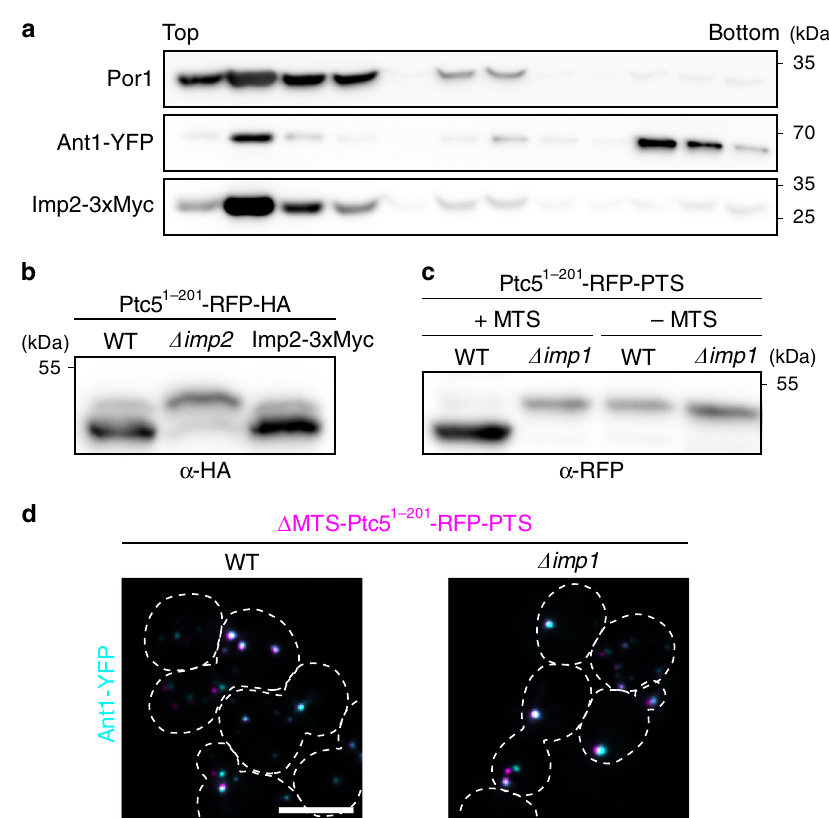
Fig. 4 The IMP complex localizes to mitochondria but not to peroxisomes. a Localization of Imp2-3xMyc was analyzed by density gradient centrifugation using puri fi ed organelles also containing the peroxisomal membrane protein Ant1 fused to YFP. Fraction were collected from the top of the gradient and analyzed by SDS – PAGE and western blot. Por1 is a protein located in the outer membrane of mitochondria. b Activity of Imp2-3xMyc was studied by analyzing the processing of the truncated Ptc5 variant Ptc5 1 – 201 -RFP-HA. c Migration of Ptc5 1 – 201 -RFP-PTS either containing ( + MTS) or lacking ( − MTS) the mitochondrial presequence was examined by SDS – PAGE and western blot. d The subcellular localization of Δ MTS Ptc5 1 – 201 -RFP-PTS was investigated using fl uorescence microscopy. White color indicates colocalization with the peroxisomal protein Ant1-YFP. Source data are provided in the Source data fi